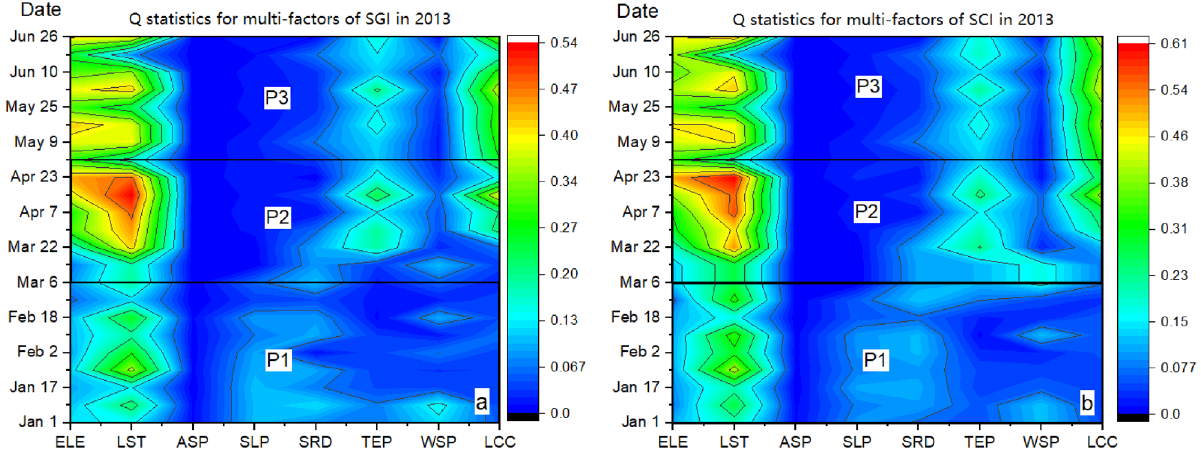
Figure 5. Variations in Q statistics for multi-factors of SGI (6.a) and SCI (6.b) in 2013. Map created in OriginPro, Version 2021. OriginLab Corporation, Northampton, MA, USA. (https:// www. origi nlab.